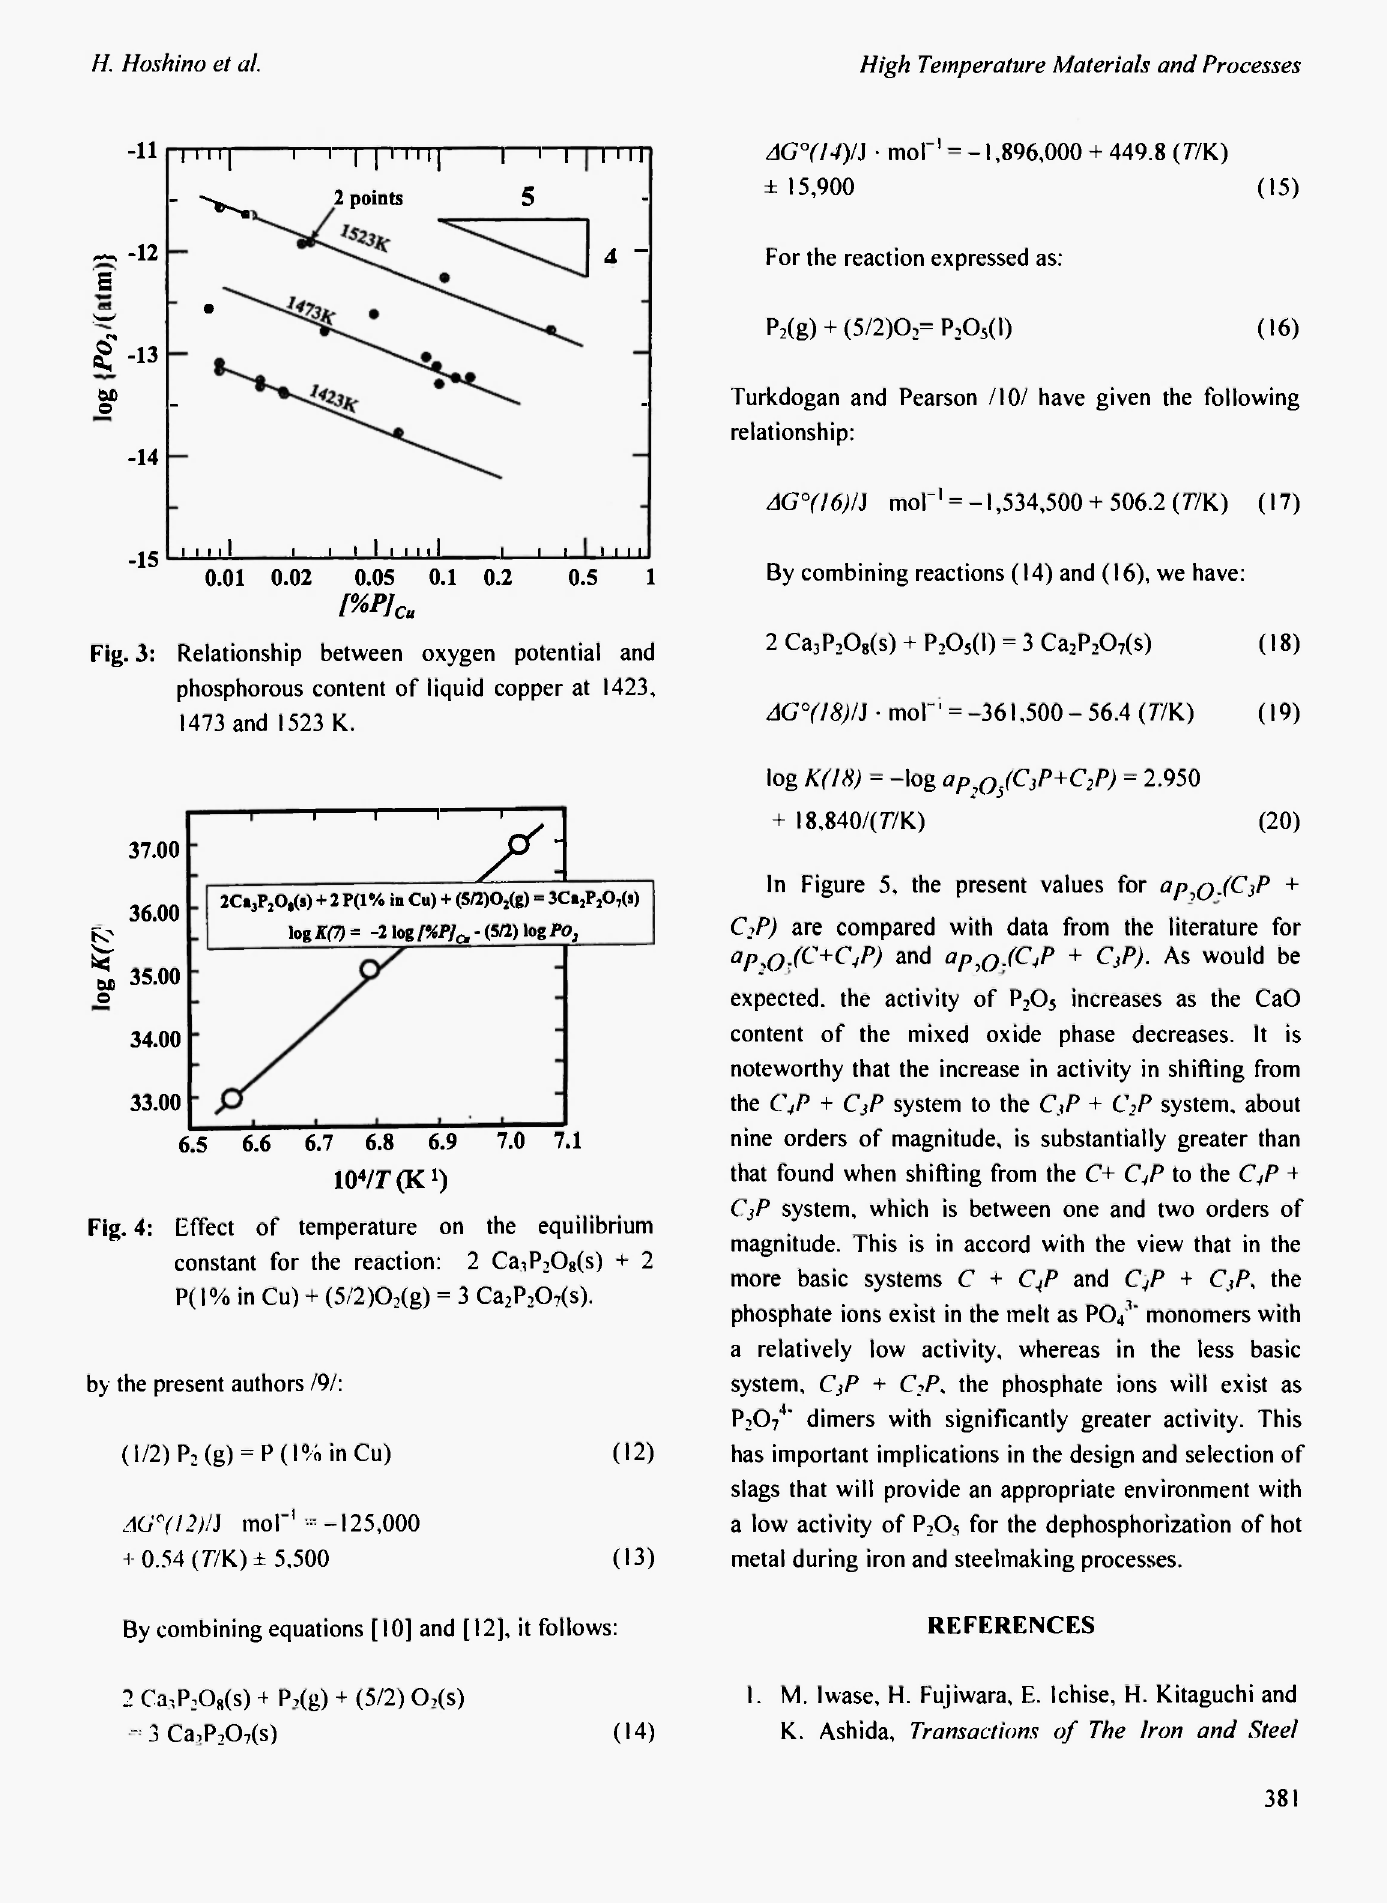
Fig. 4: Effect of temperature on the equilibrium constant for the